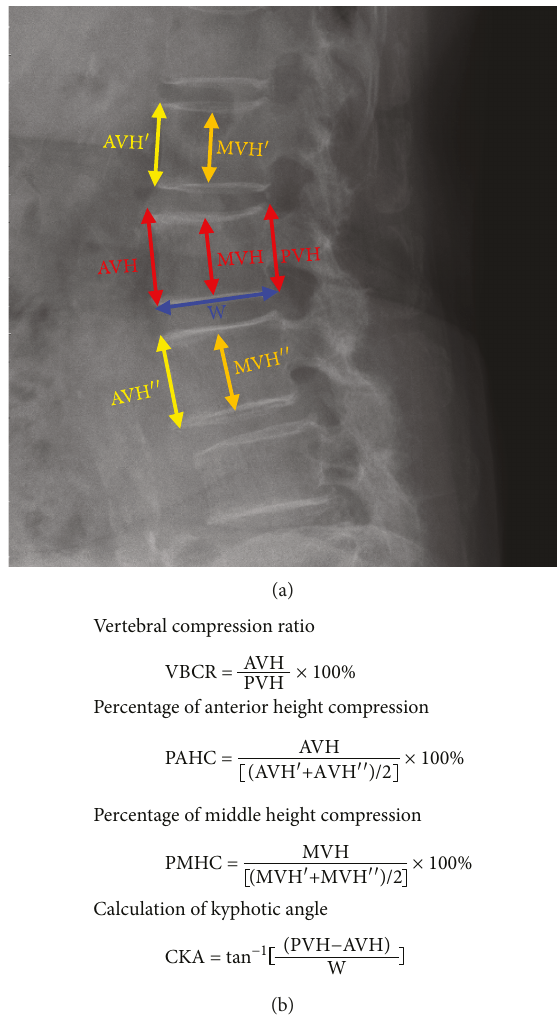
Figure 1: (a) This study mainly measures the characteristic lengths on plain radiographs (AVH: anterior vertebral height; MVH: middle vertebral height; PVH: posterior vertebral height; W: vertebral body width). (b) Parameters examined in this study (VBCR, PAHC, PMHC, and